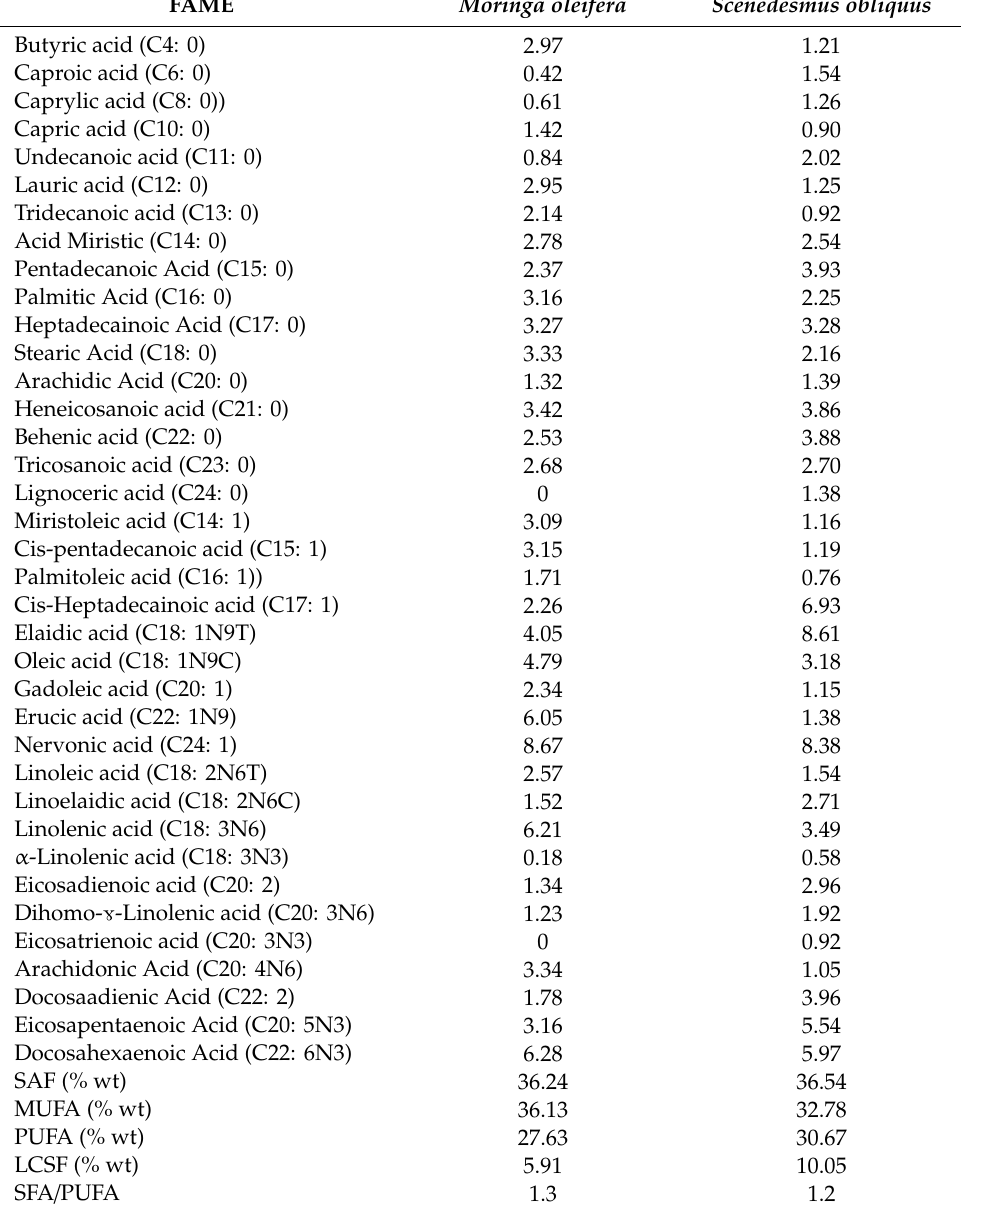
Table 8. Methyl Esters Fatty Acids Profile ( FAME ) (% w / w ) of Moringa oleifera and microalgae S. obliquus harvested after